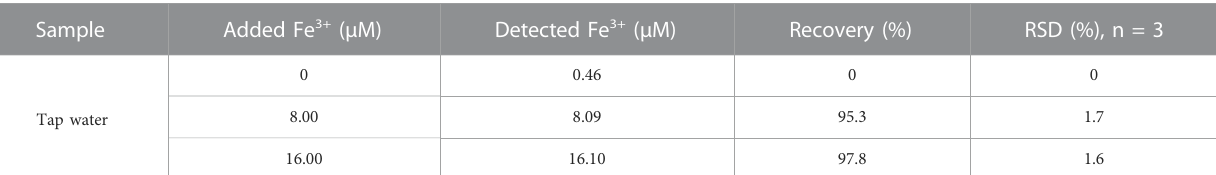
TABLE 1 Results for the determination of Fe 3+ of tap water.